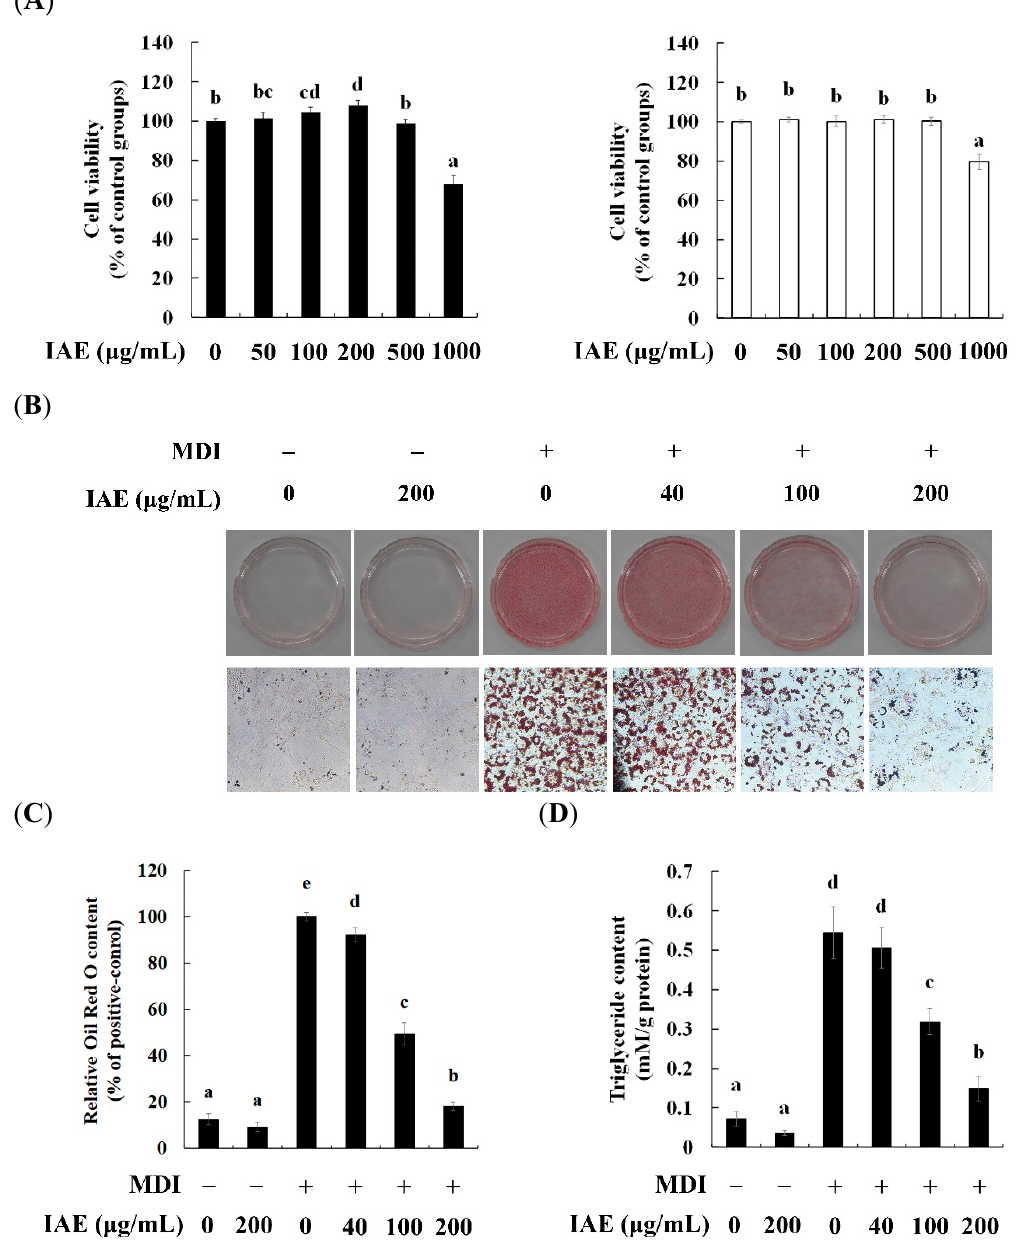
Figure 1. Inula britannica flower aqueous extract (IAE) inhibits lipid accumulation without exerting cytotoxic effects during the differentiation of 3T3-L1 preadipocytes. The cells were induced to differentiate by the MDI upon treatment with IAE in indicated concentrations. ( A ) The effect of IAE on cell viability was evaluated with the MTT assay ( ■ , cell viability of preadipocytes; □ , cell viability of differentiated preadipocytes). ( B ) Oil Red O staining of intracellular lipids on day 8. ( C ) Relative absorbance of Oil Red O eluted from intracellular lipids at 500 nm. ( D ) Measurement of intracellular triglyceride levels on day 8. The data are presented as mean ± standard deviation. Values labeled with different letters are significantly different ( p < 0.05). Differences among the multiple groups were determined based on one-tailed one-way analysis of variance, followed by Tukey's post hoc test.